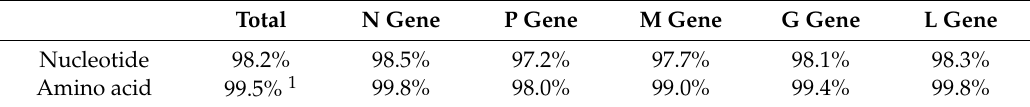
Table 1. Homology of each viral gene between the Koma and RV303 at nucleotide and amino acid levels. Total N Gene P Gene M Gene G Gene L Gene Nucleotide 98.2% 98.5% 97.2% 97.7% 98.1% 98.3% Amino acid 99.5% 1 99.8% 98.0% 99.0% 99.4% 99.8% 1 Average of amino acid homologies of all five viral proteins.